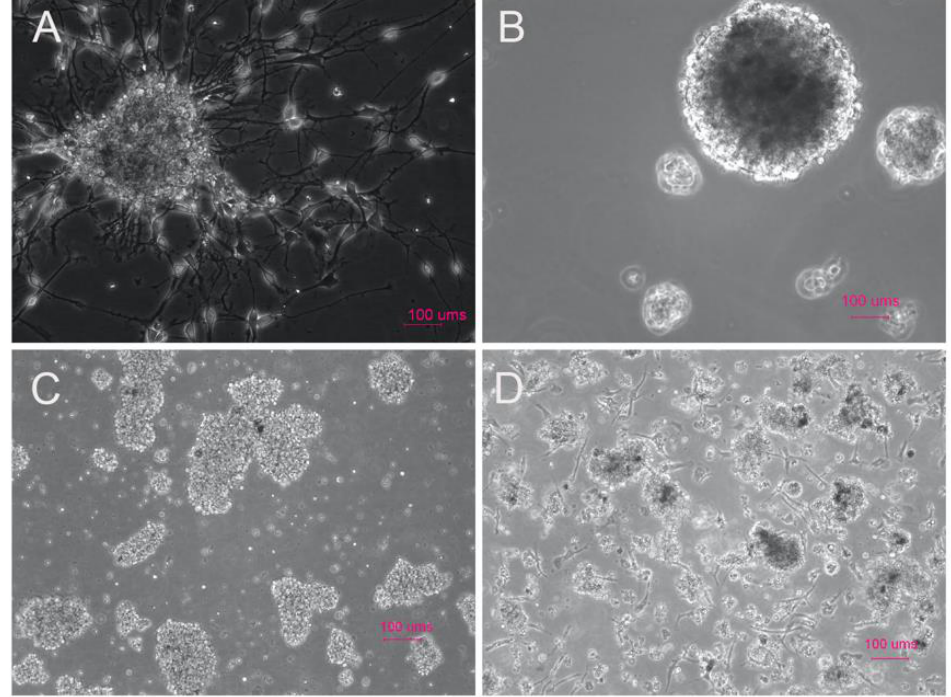
Figure 2. Patient-derived glioma stem cells (GSCs) from histologically confirmed GBM less than 7 days post dissociation in serum-free media demonstrating a wide range of phenotypes which all resulted in intracranial tumor growth in NOD scid gamma (NSG) mice. ( A ) Patient-derived cells from case 2025, a newly-diagnosed GBM; ( B ) patient-derived cells from case 2033, a multifocal GBM; ( C ) patient-derived cells from case 2188, a recurrent GBM; and ( D ) patient-derived cells from case 2216 from a newly-diagnosed GBM. All four have distinguishing characteristics of adherent neurospheres ( A ), large 3-dimensional neurospheres (B), and small clumps of cells with adherent cell populations (C,D) However, all form orthotopic xenografts which grow at increasing rates in successive generations. (Scale bar = 100 µ m).